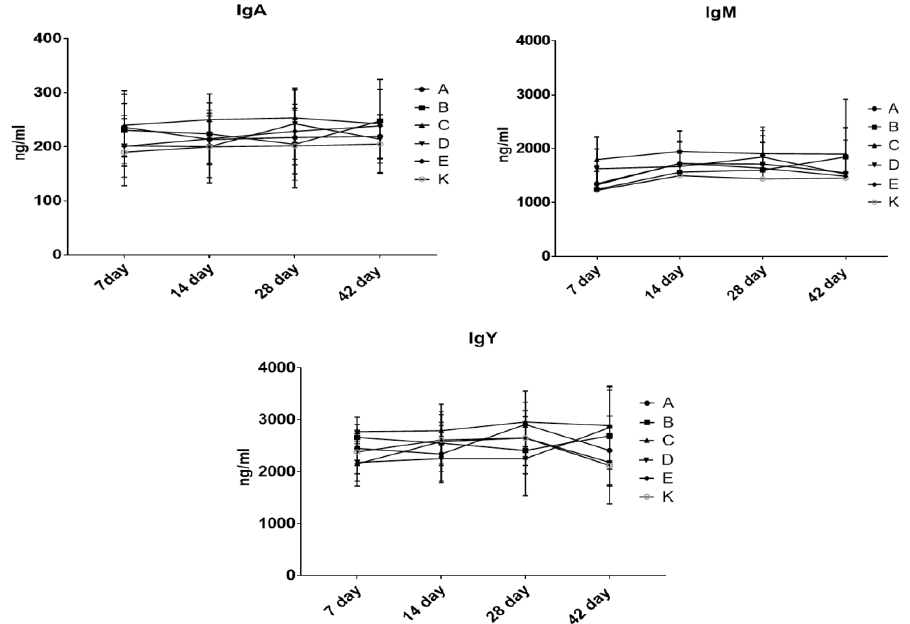
Figure 4. Levels of IgY, IgM and IgA in the chicken blood.